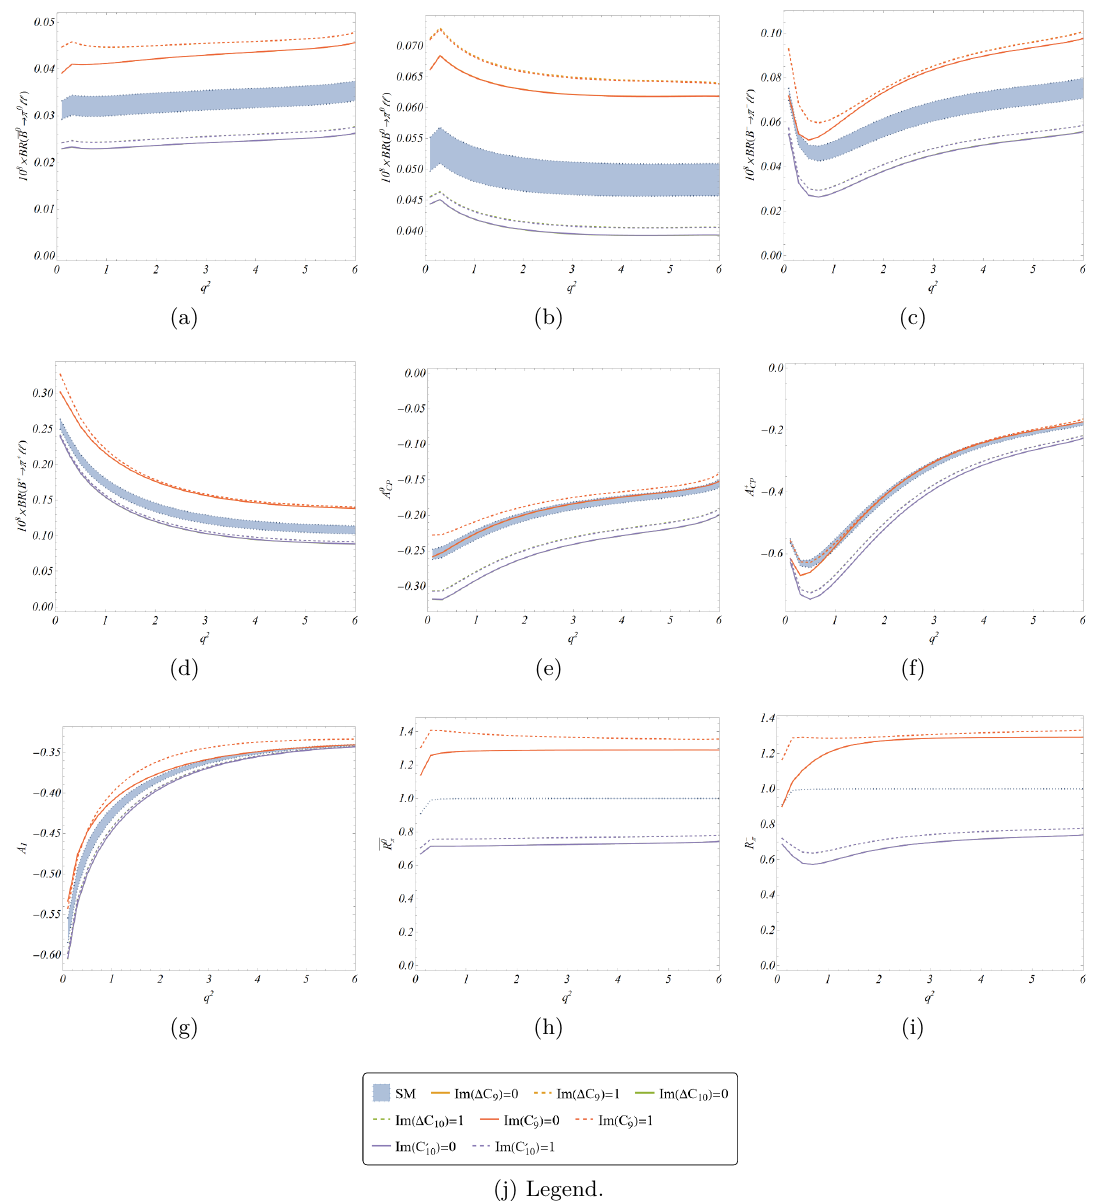
Figure 1 . The q 2 dependence for the B → πll observables in the SM and the four different NP scenarios with NP Wilson coefficients ∆ C and C 0 . For the NP scenarios, the plots show the 9 , 10 9 , 10 corresponding dependence of the observables on the imaginary parts of the respective NP’s for the two different benchmark values 1 and 0 of the imaginary parts of the WC’s while the real part is fixed at 1. For detail, please see the